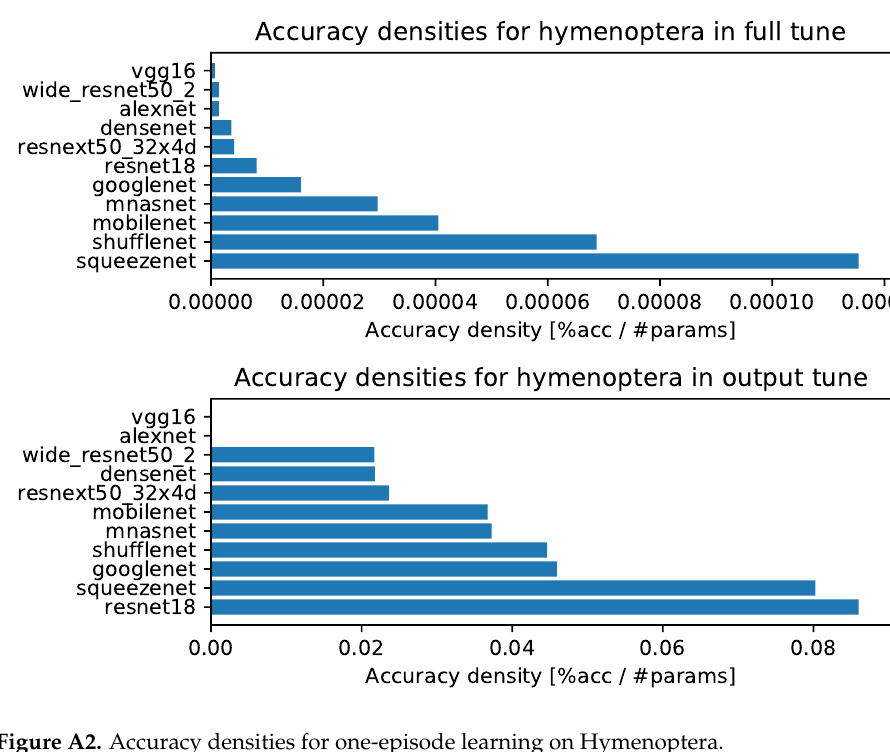
Figure A2. Accuracy densities for one-episode learning on